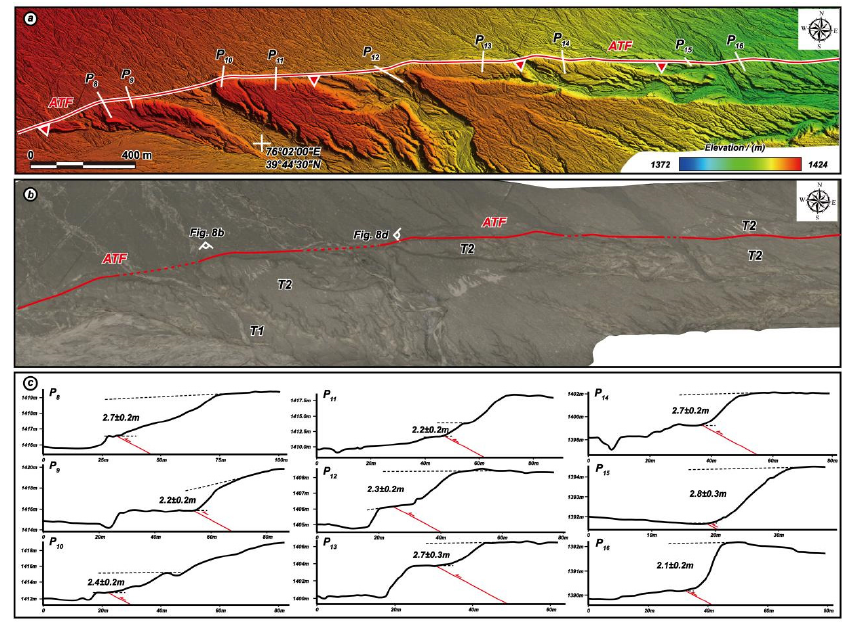
Figure 6. The tectono-geomorphic features in the western Aqike village (site 3 as shown in Figure 3b) ( a ) The DSM generated by the UAV-based photogrammetry showing a linear fault scarp developed on the T2 surface; ( b ) the UAV DOM-based 3D perspective image showing the geomorphic details of fault scarp along the ATF (red dashed lines); ( c ) the measured throws along the fault, and the locations of profile are shown in Figure 6a.